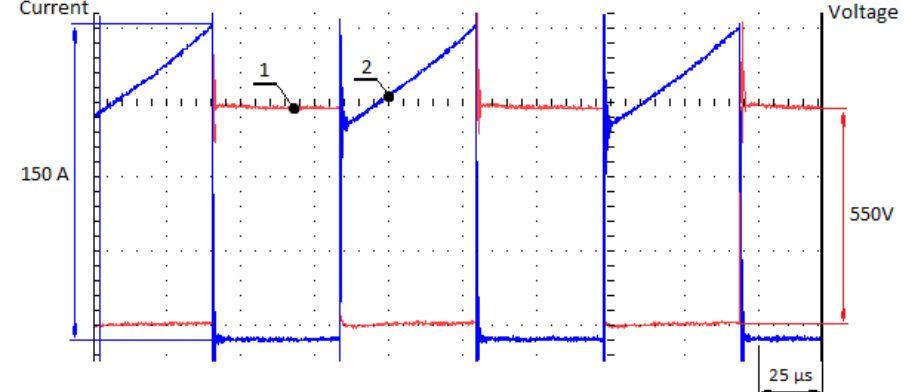
Figure 11. Buck mode of operation. 1–voltage gate-to-source Q1 (module M1, Figure 2), 2–current through transistors Q1. Snubber capacitors are not included.